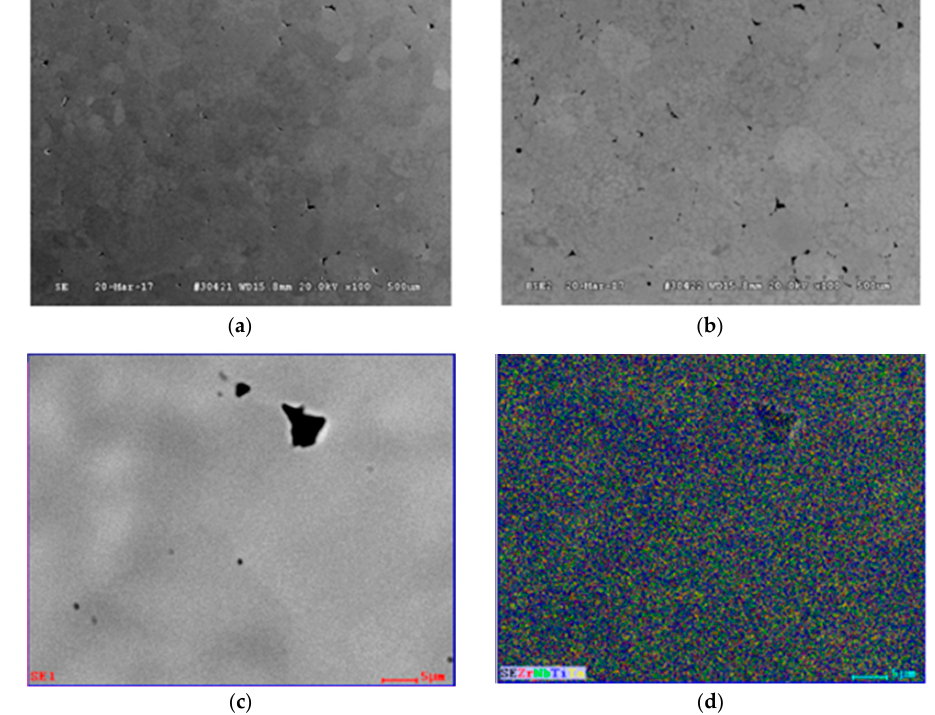
Figure 5. SEM ( a – c ) and EDS ( d ) analysis TNZT sample sintered at 600 °C with 60 MPa and 15 min of holding time that shows 85% of relative density and contains no unreacted titanium. In the map shown in ( d ), the Red refers to Zr, Green to Nb, Blue to Ti, and Yellow to Ta. The amount of reacted/unreacted titanium can be correlated with the SPS parameters as temperature, pressure, and holding time are shown to have an influence on promoting the diffusion of elements in the titanium.